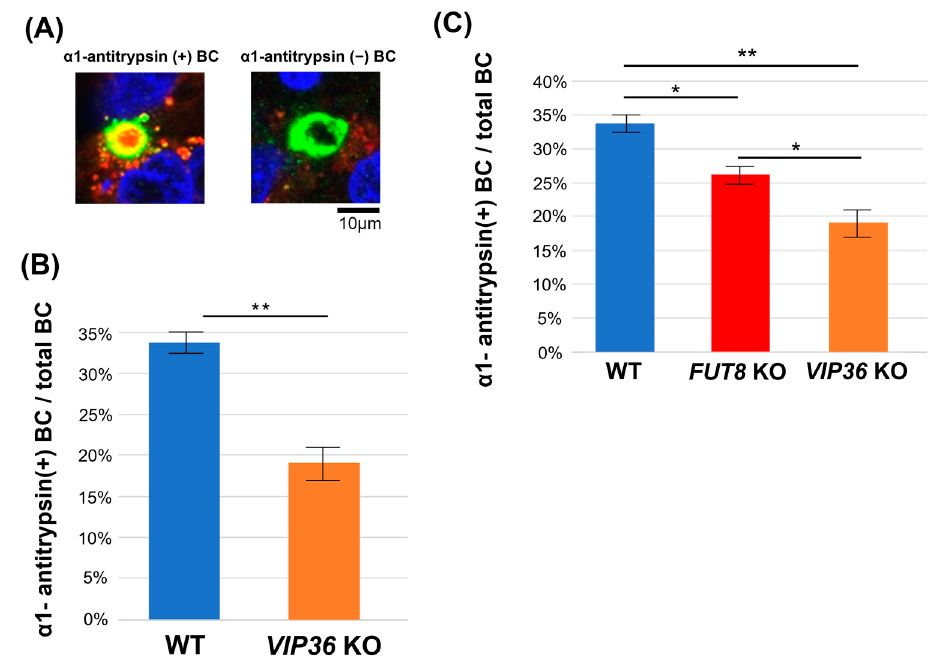
Figure 5. Accumulation of alpha-1 antitrypsin in bile duct-like structures was reduced by VIP36 KO in HepG2 cells. ( A ) Representative images of bile duct-like structures formed on HepG2 cells and stained with anti-alpha-1 antitrypsin (red) and anti-MRP2 (green) antibodies. Histogram shows the percentage of anti-alpha-1 antitrypsin antibody co-positive cells in 30 randomly selected visual fields from images of WT and VIP36 -KO HepG2 cells stained with anti-MRP2 antibody. ( B ) The percentage of anti-alpha-1 antitrypsin antibody and anti-MRP2 antibody co-positive cells in 30 ran- domly selected visual fields from images of WT and VIP36 -KO HepG2 cells. ( C ) The percentage of anti-alpha-1 antitrypsin antibody and anti-MRP2 antibody co-positive cells in 30 randomly selected visual fields from images of WT, FUT8 -KO, and VIP36 -KO HepG2 cells. BC: bile canaliculus (bile duct-like structure). Results are expressed as the mean +/ − SD. * p < 0.05, ** p < 0.01. 3. Discussion For over 15 years, we have searched for cargo receptors for fucosylated proteins in hepatocytes and the liver. However, we failed to identify such lectin-like molecules using glycan affinity chromatography. Fut8 -deficient mice have low levels of alpha-1 acid gly- coprotein and alpha-1 antitrypsin in bile, although these glycoproteins are abundant in the blood of Fut8 -deficient mice [19]. Cell fractionation of WT and FUT8 -KO HepG2 cells showed different patterns of glycoproteins within endosomes (Figure 3). This data strongly implies there is a selective secretion of fucosylated glycoproteins in the liver. The recently established Strep-tag/Strep-Tactin system enables the detection of intracellular expression of a tag-labeled target protein, and coprecipitating molecules can interact with the protein of interest using beads that strongly bind to the tag. This system reduces noise, as it is not affected by the nonspecific adsorption of antibodies. Using this method, we identified approximately 200 proteins anticipated to interact with AFP in WT and FUT8 - KO HepG2 cells (Supplemental Figure S1B). Interestingly, we detected more glycopro- teins in the bile duct-like structures in WT HepG2 cells than in FUT8 -KO HepG2 cells, suggesting that the core fucose is involved in the selection of bile duct-related proteins to be secreted (Supplemental Figure S1C). In fact, the bile duct-like structures in FUT8 -KO HepG2 cells changed in shape or size. A variety of lectin-like molecules were also